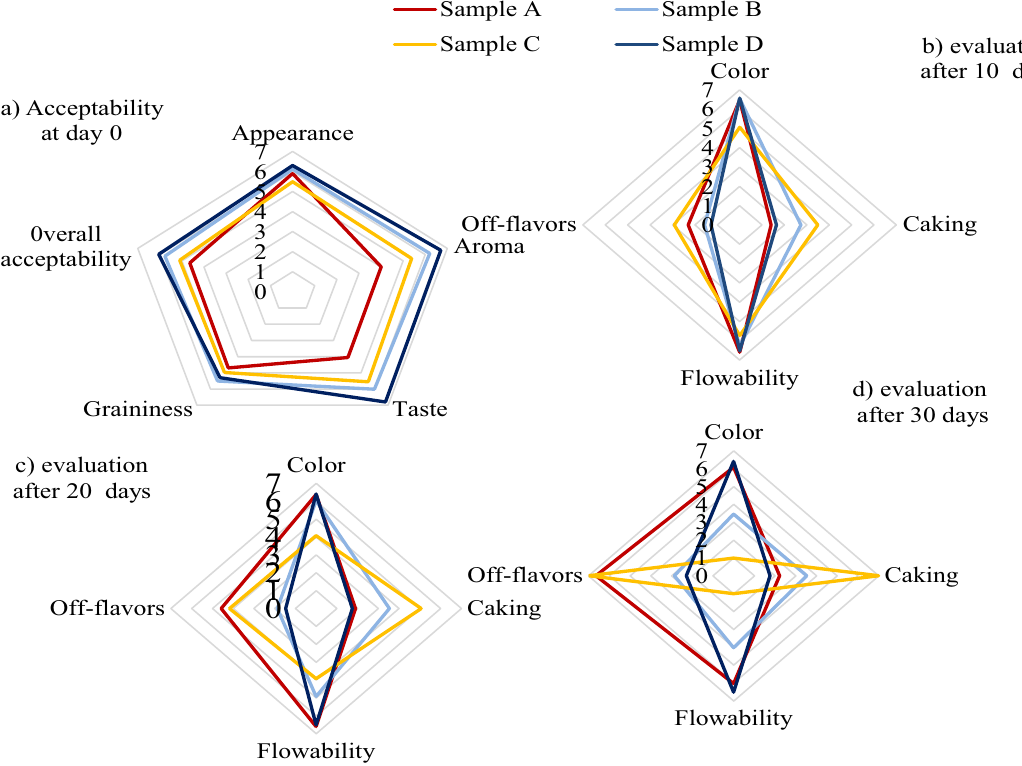
Figure 4. Sensory evaluation of yak butter powders before and during accelerated